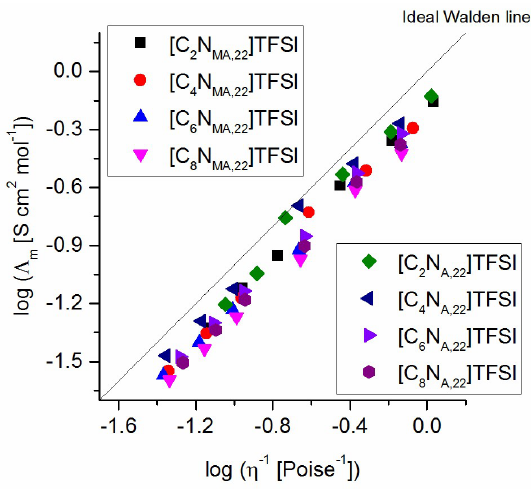
Figure 8. Walden plot for the studied TFSI ionic liquids.